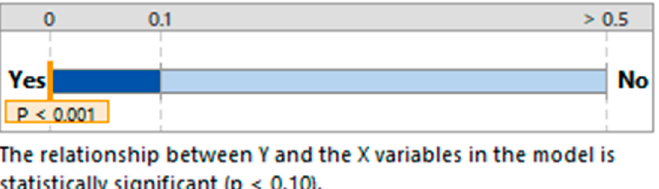
Figure 6. Statistic p.